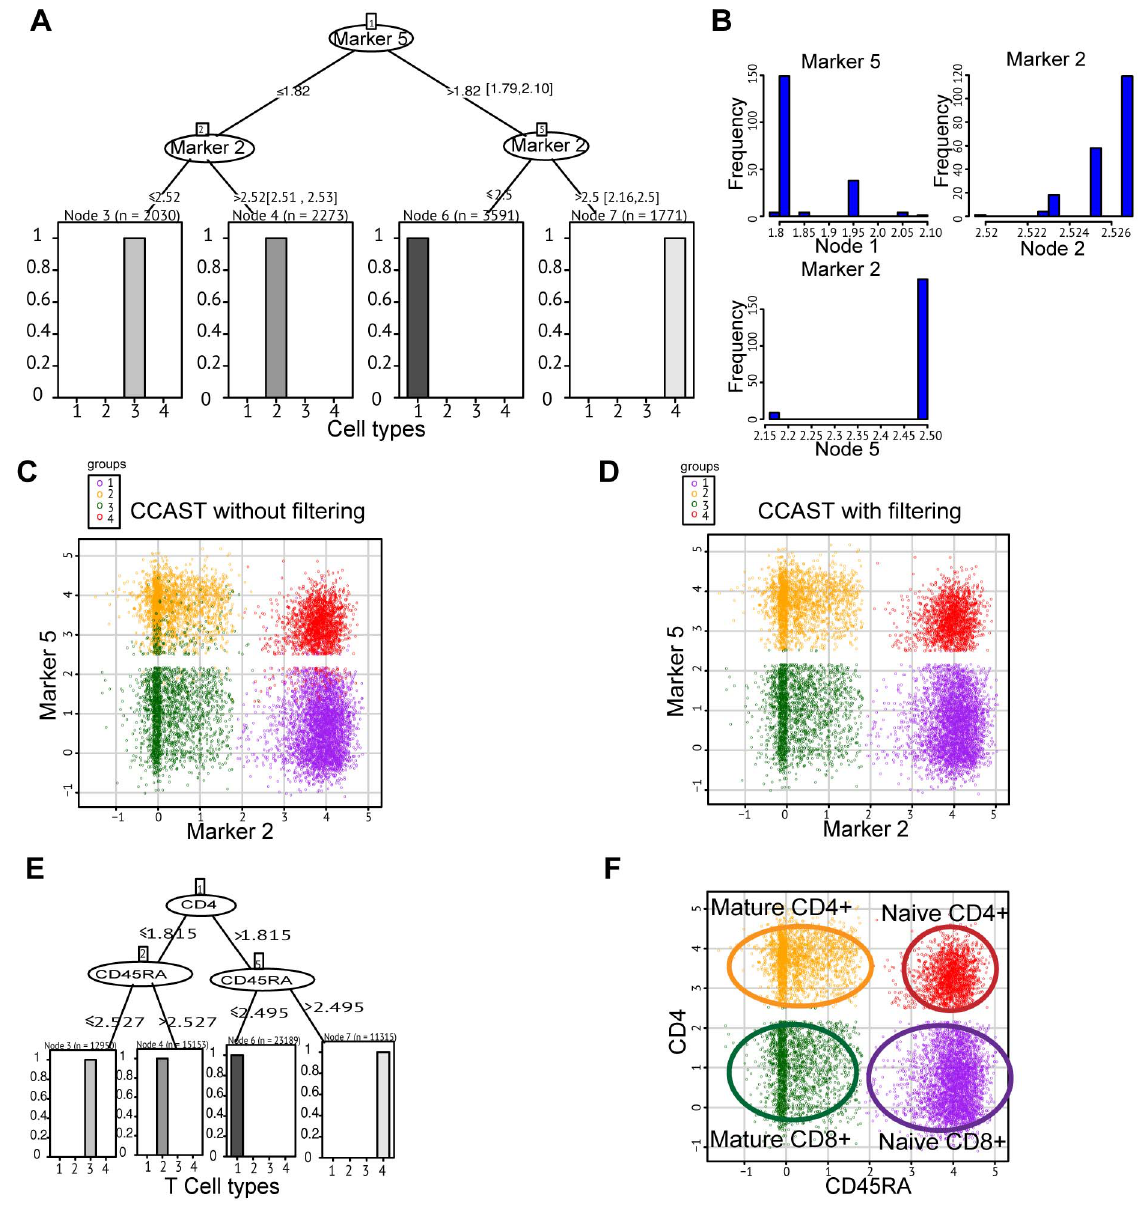
Figure 3. CCAST applied to single cell analysis of T-cells. A The CCAST gating strategy based on the unlabeled T-cell data in Figure 2, post filtering, showing that 4 cell types can be derived using only Marker 5 and Marker 2 with Marker 5 as the root node. Split points along with the minimum-maximum range for each split point are provided at each node. B Histogram plots for sample split point for each node is obtained via bootstrapping. The multi modal nature of the distributions makes it difficult to calculate a true confidence intervals on the split point estimates. C CCAST result without filtering represented as a 2D scatter plot of the 4 cell types, which each cell type color coded; note that gating the yellow- colored cells will likely result in contamination of green-colored cells. D CCAST result with filtering represented as a 2D scatter plot of the 4 pure cell types, with each cell type color coded. Note all contaminating cells mixed with various clusters have been removed. For manual gating purposes, comparing the two schemes C and D provides a visual evaluation of the expected contamination levels from sorting subpopulations. E CCAST gating strategy for all Tcell types with labels reveals that the key gating markers are CD4 and CD45RA markers. F 2D scatter plot for the four, labeled T-cell types based on CD4 and